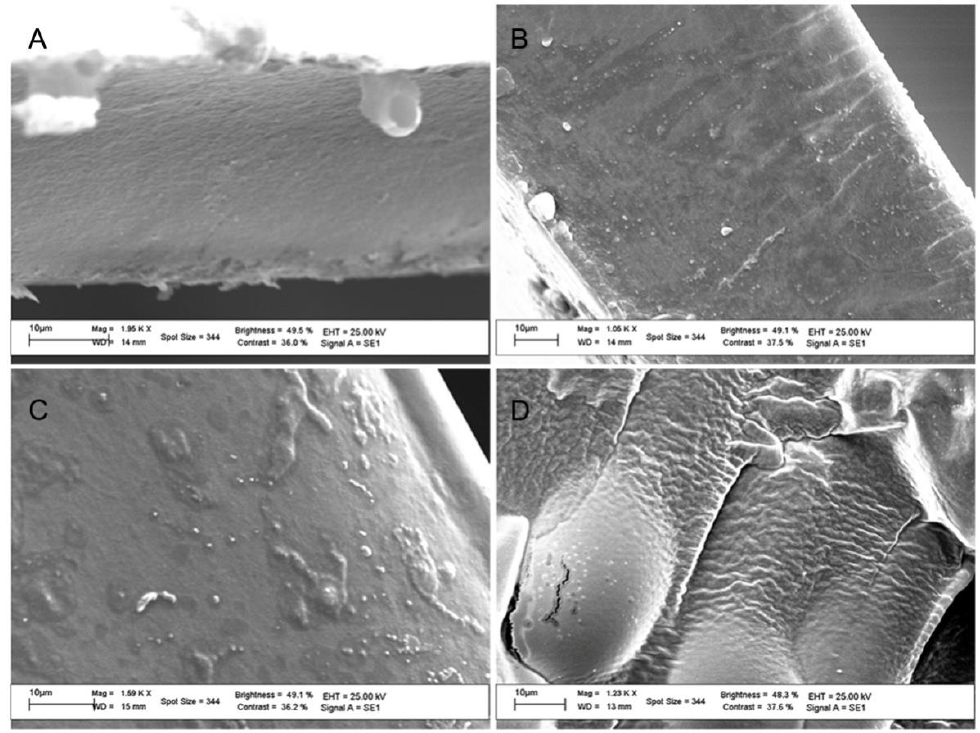
Figure 2. SEM images of CS ( A ), CS/HA5 ( B ), CS/HA25( C ) and CS/HA35 ( D ) films.